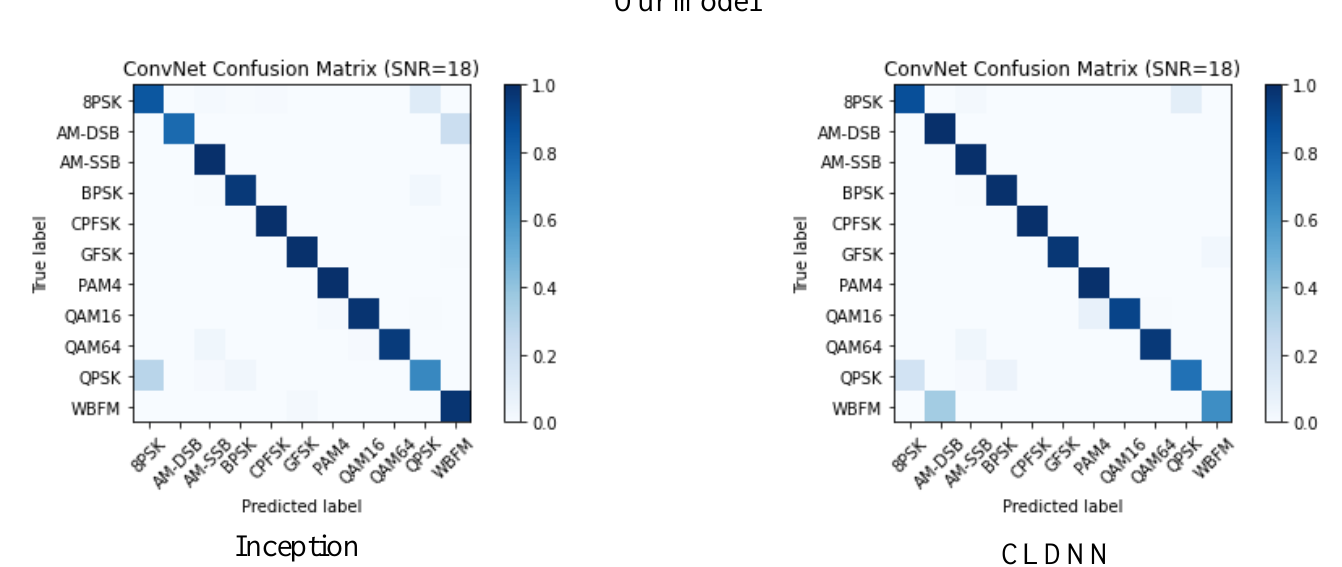
Figure 10. Confusion matrices for different models when SNR = 18